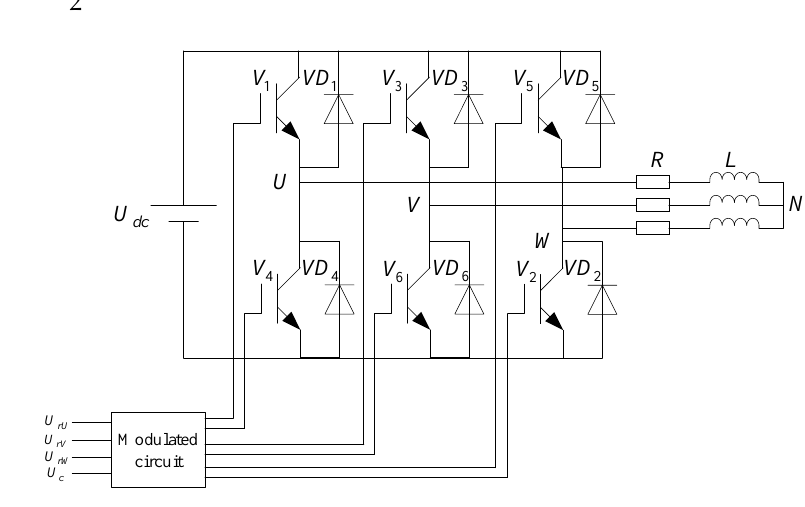
Figure 1. Three-phase inverter.